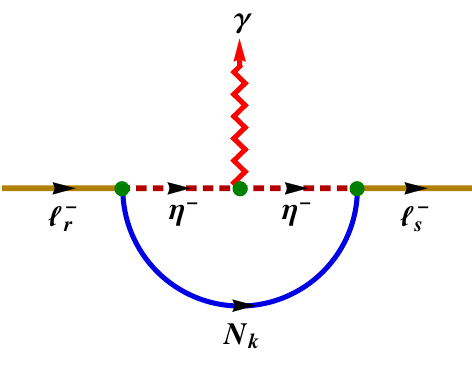
Figure 2 . Feynman diagram of (cid:13)avor-changing radiative decay ‘ r ! ‘ s (cid:13)